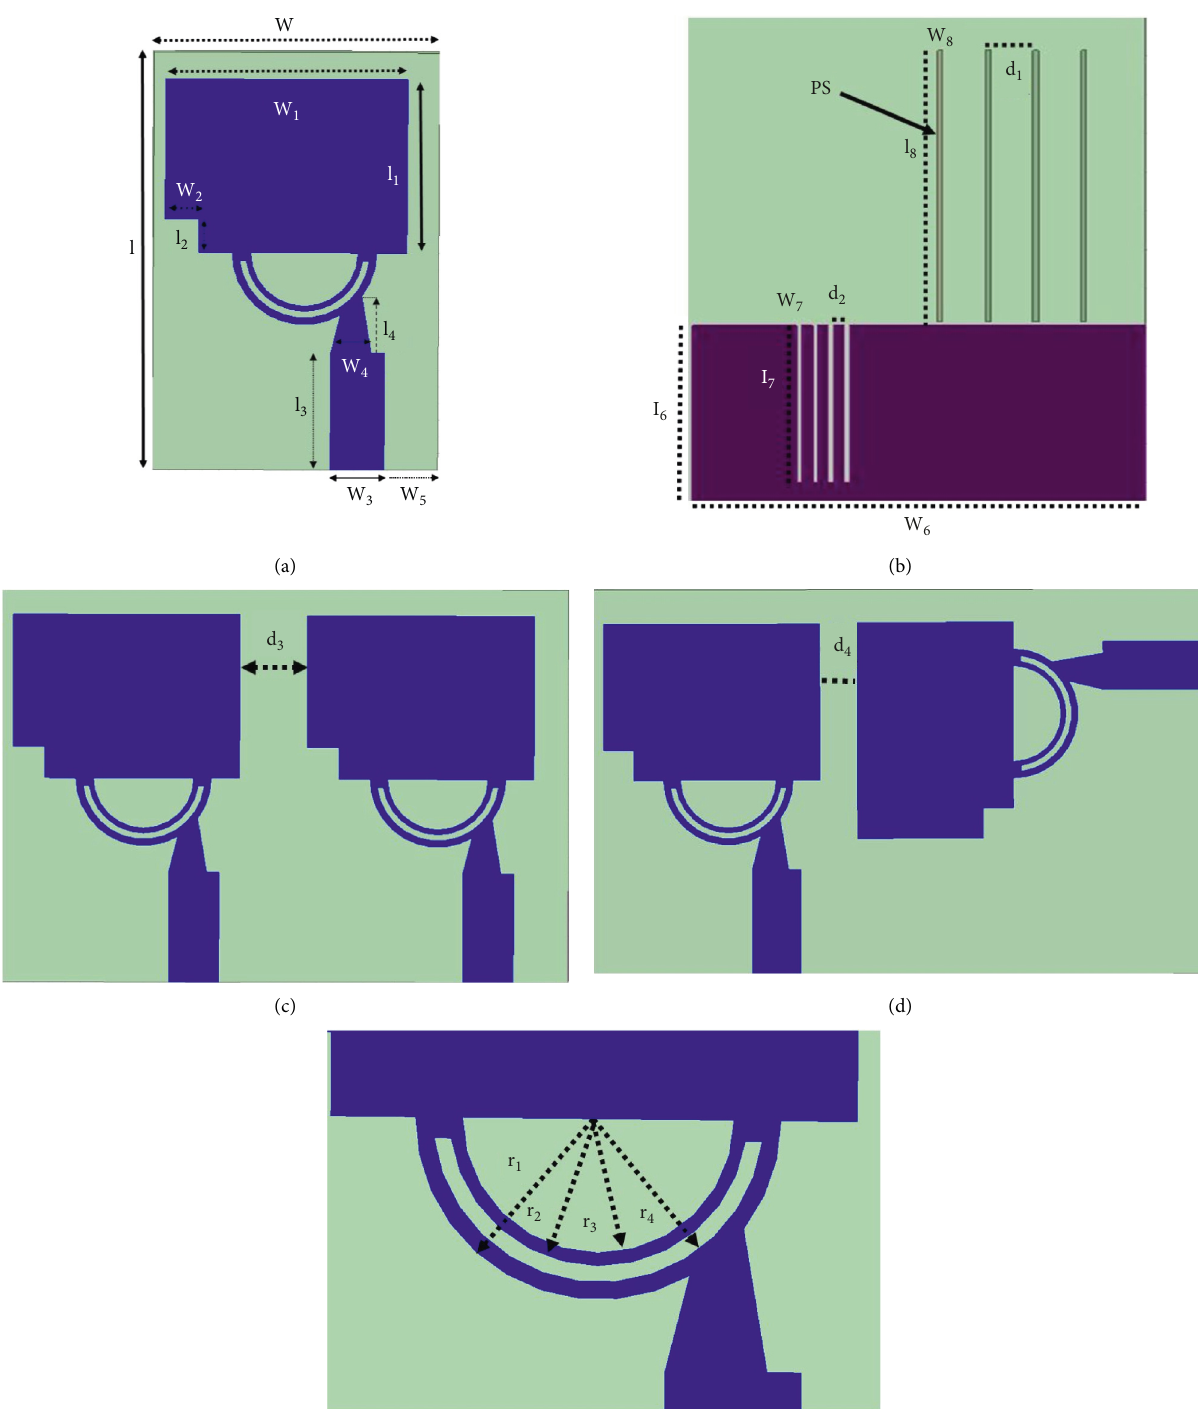
Figure 1: (a) Front view, (b) back view, (c) cross-MIMO, (d) co-MIMO, and (e) internal